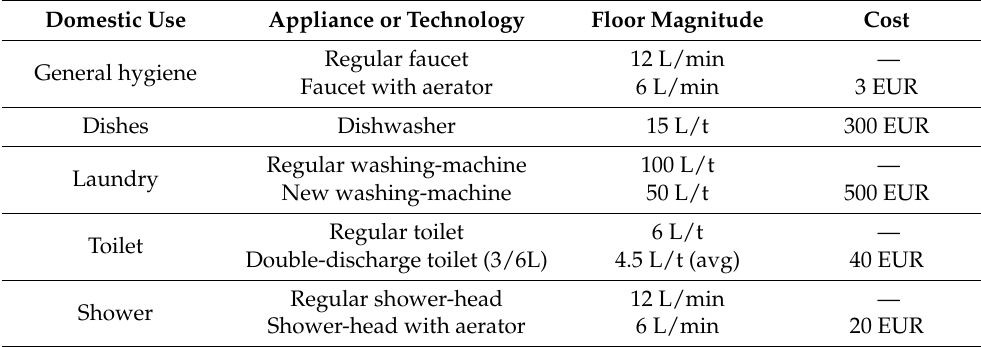
Table 3. Water technologies considered for household.